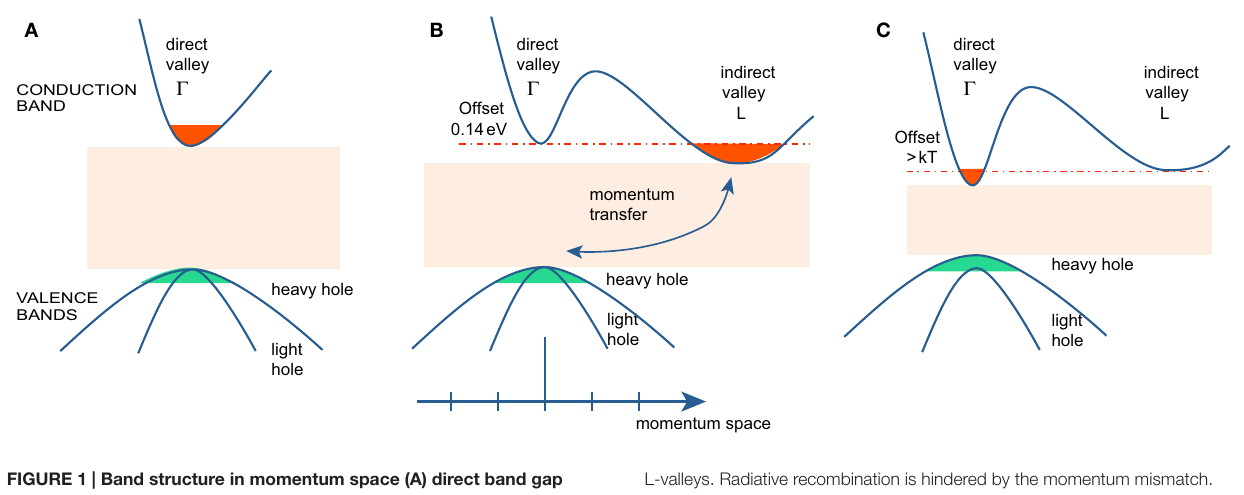
FiGURe 1 | Band structure in momentum space (A) direct band gap semiconductor . Electron/hole recombination occurs at the Γ -point. (B) Unstrained Ge. Electrons occupy the conduction band states of the